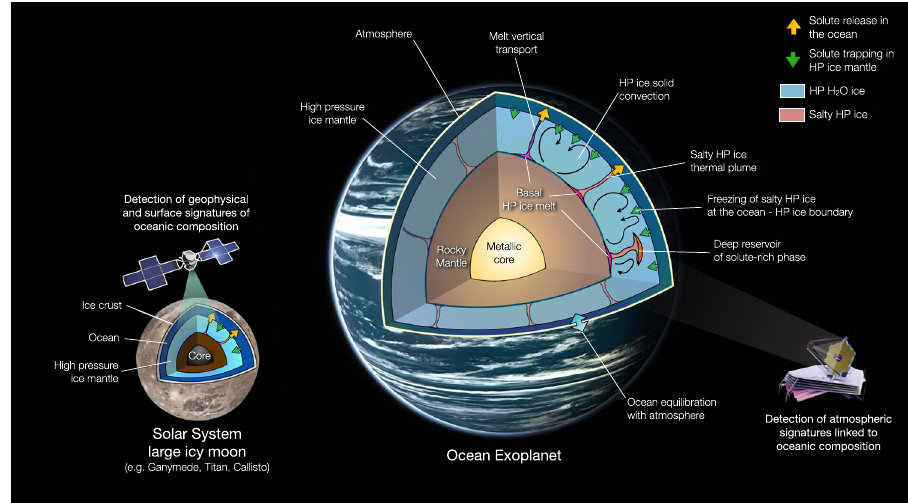
Fig. 1 Schematic interior structure, dynamic and solute transport and cycling processes inside an ocean super-Earth and an icy moon of our solar system with high-pressure ice (Titan, Ganymede and Callisto). Basal melt enriched in solutes and nutrients at the base of the high-pressure ice mantle can be generated by various geological processes like hydrothermal sources, mineral aqueous alteration or volcanic activity. Vertical transport processes like buoyant liquid migration, salty high-pressure (HP) ice thermal plumes, solid-state convection and freezing at the bottom of the ocean into salty HP ice are reported. Possible trapping mechanisms like the formation of stable solute-rich phase reservoir within the HP ice mantle are also illustrated. The thermodynamic and chemical equilibration of the ocean with the atmosphere could lead to atmospheric spectral signatures linked to the ocean composition, detectable by modern and next generation telescopes like the JWST. For icy moons, geophysical and surface signature of the ocean composition will be investigated by upcoming planetary robotic mission ESA JUICE, NASA DragonFly. Background of icy moon Ganymede (NASA/Galileo); Ocean Exoplanet texture generated with PlanetMaker